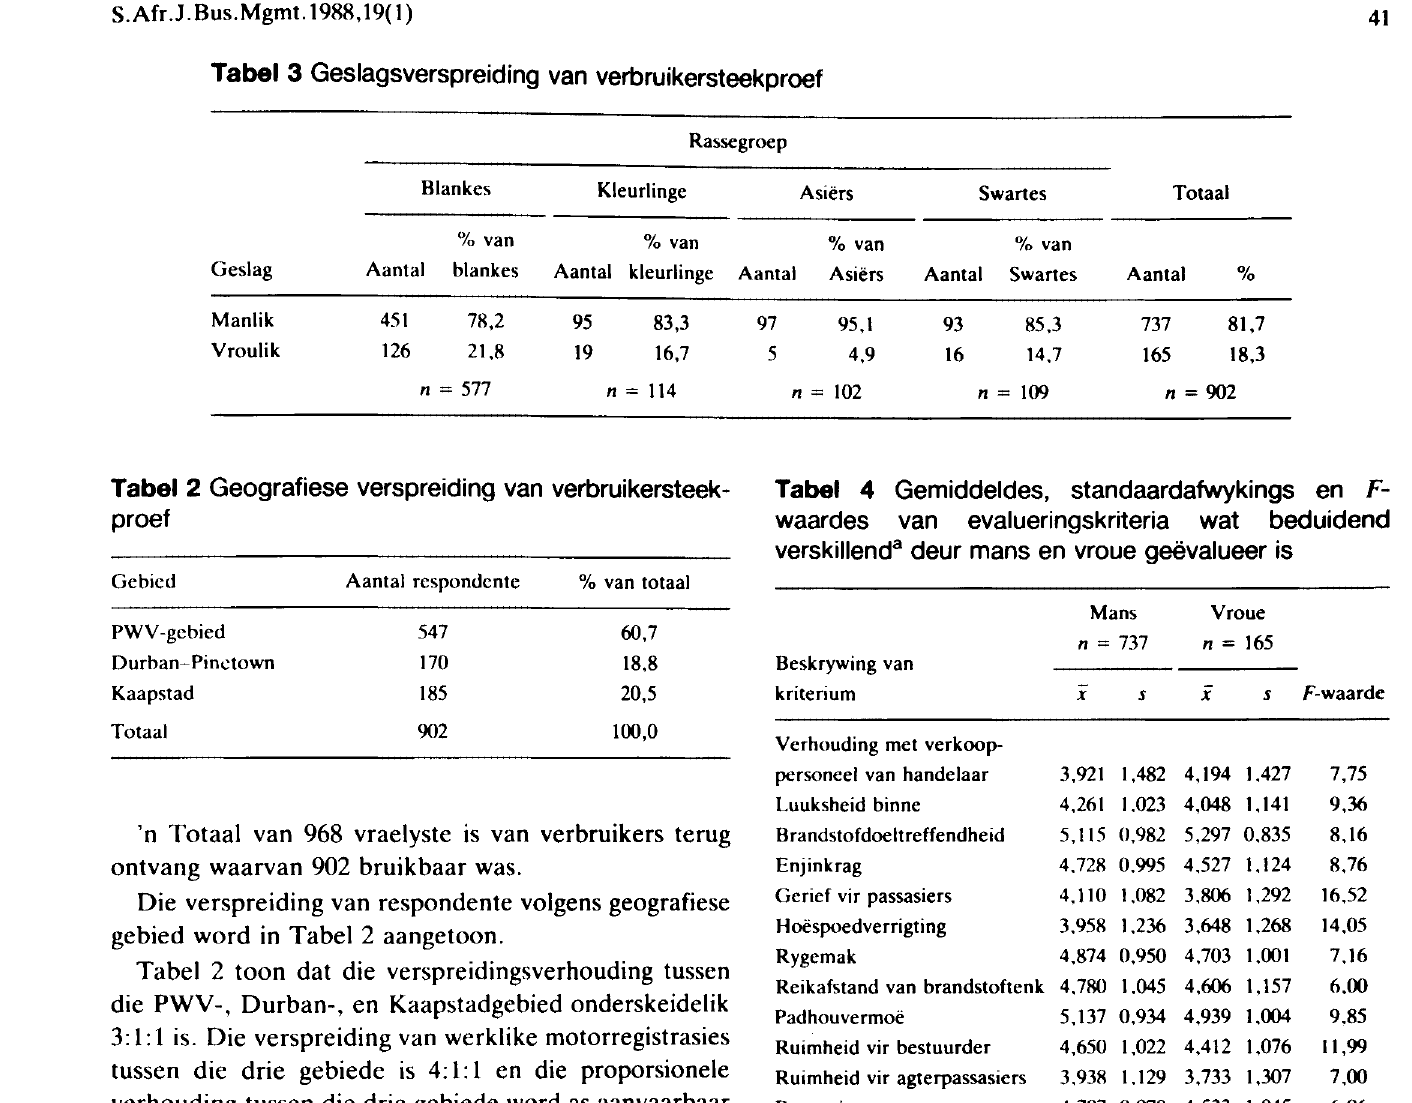
'n Totaal van 968 vraelyste is van verbruikers terug ontvang waarvan 902 bruikbaar was.